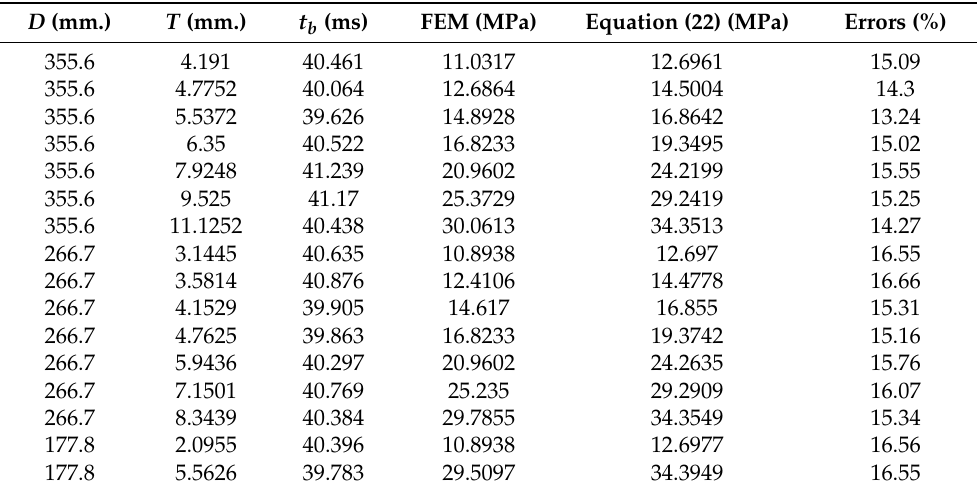
Table A2. Comparisons between the FEM results and the predictions, when t d = 39 ms.